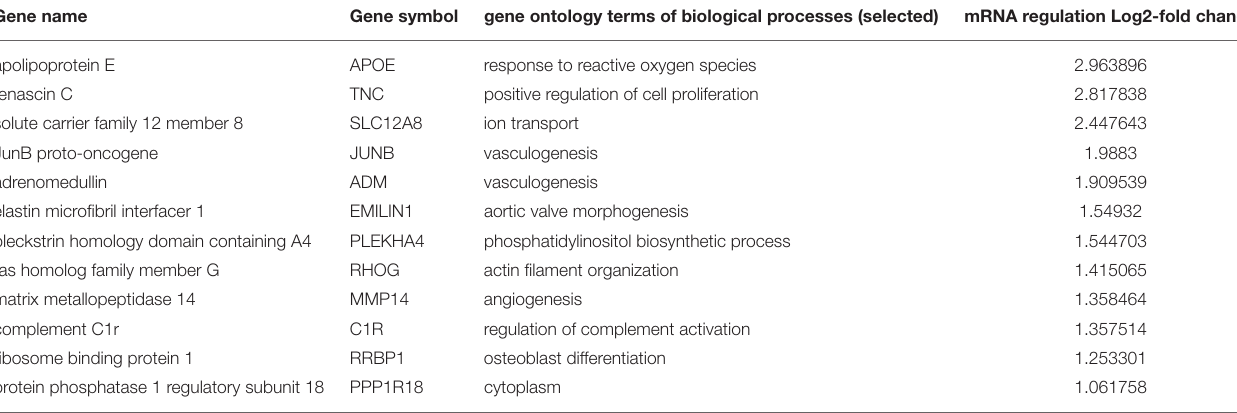
TABLE 5 | DMM overlap with up-regulated DEGs.